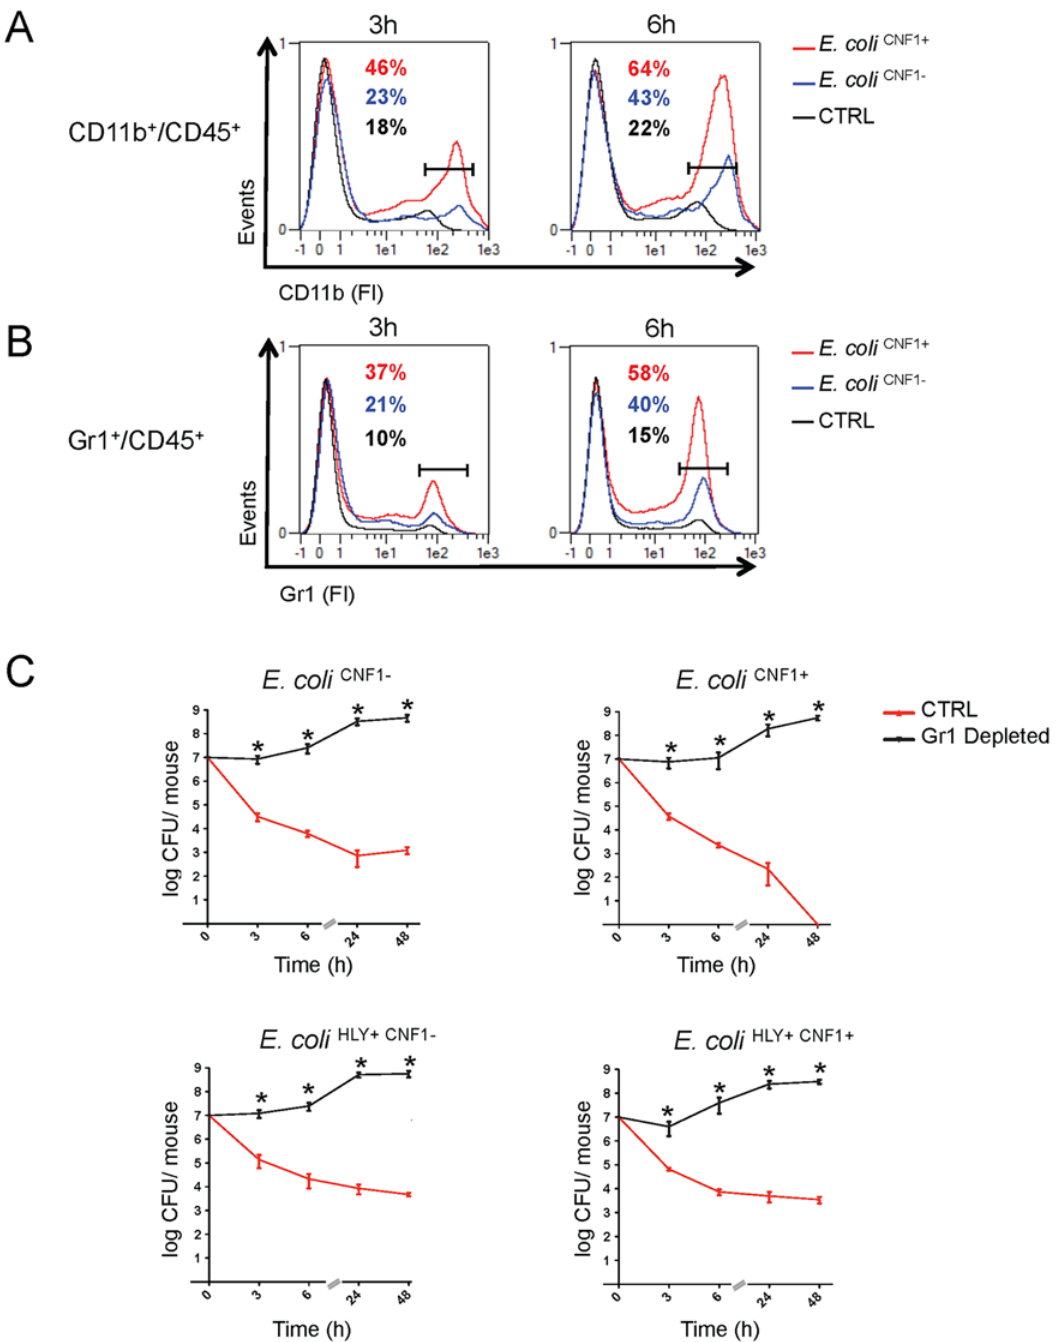
Fig 6. Gr1 + cell subpopulations are necessary for the rapid clearance of the CNF1 + strain from the blood. (A and B) Flow cytometry analysis of peripheral blood isolated from mice intravenously infected with 10 7 CFUs of E . coli CNF1+ , E . coli CNF1- or PBS (control). Percentages of cells expressing (A) CD45 and CD11b or (B) CD45 and Gr1 are indicated (n = 5). (C) BALB/c mice were injected either with an anti-Gr1 antibody or vehicle, and after 48 h, they were inoculated intravenously with 10 7 CFUs of E . coli HLY+CNF1+ or with 10 7 CFUs of one of the isogenic mutants, E . coli CNF1+ , E . coli HLY+CNF1- , or E . coli CNF1- , prior to the collection of peripheral blood at 3, 6, 24 and 48 h for the measurement of CFUs via the plating of serial dilutions. P-values < 0.05 ( * ) were considered statistically